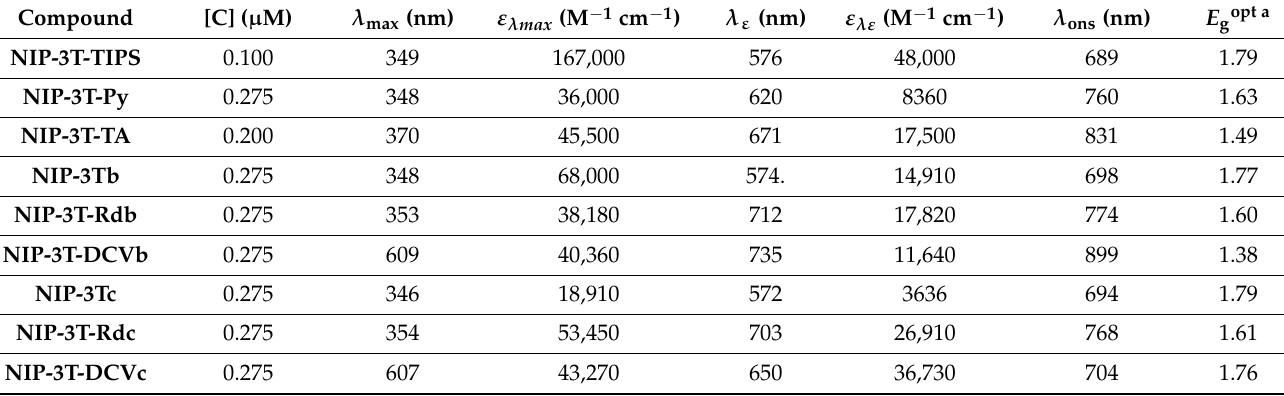
Table 9. Optical properties for the semiconductors based on end-capped thienopyrazine semiconductors measured in CHCl 3 solution.